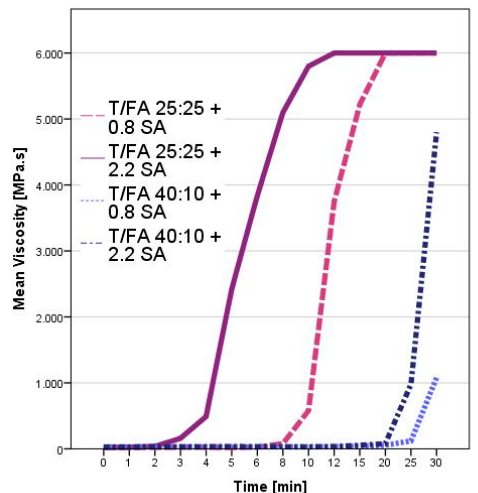
Figure 3. Viscosity behavior of tannin-FA formulations depending on the ratio T:FA and on the amount of sulfuric acid (SA) as